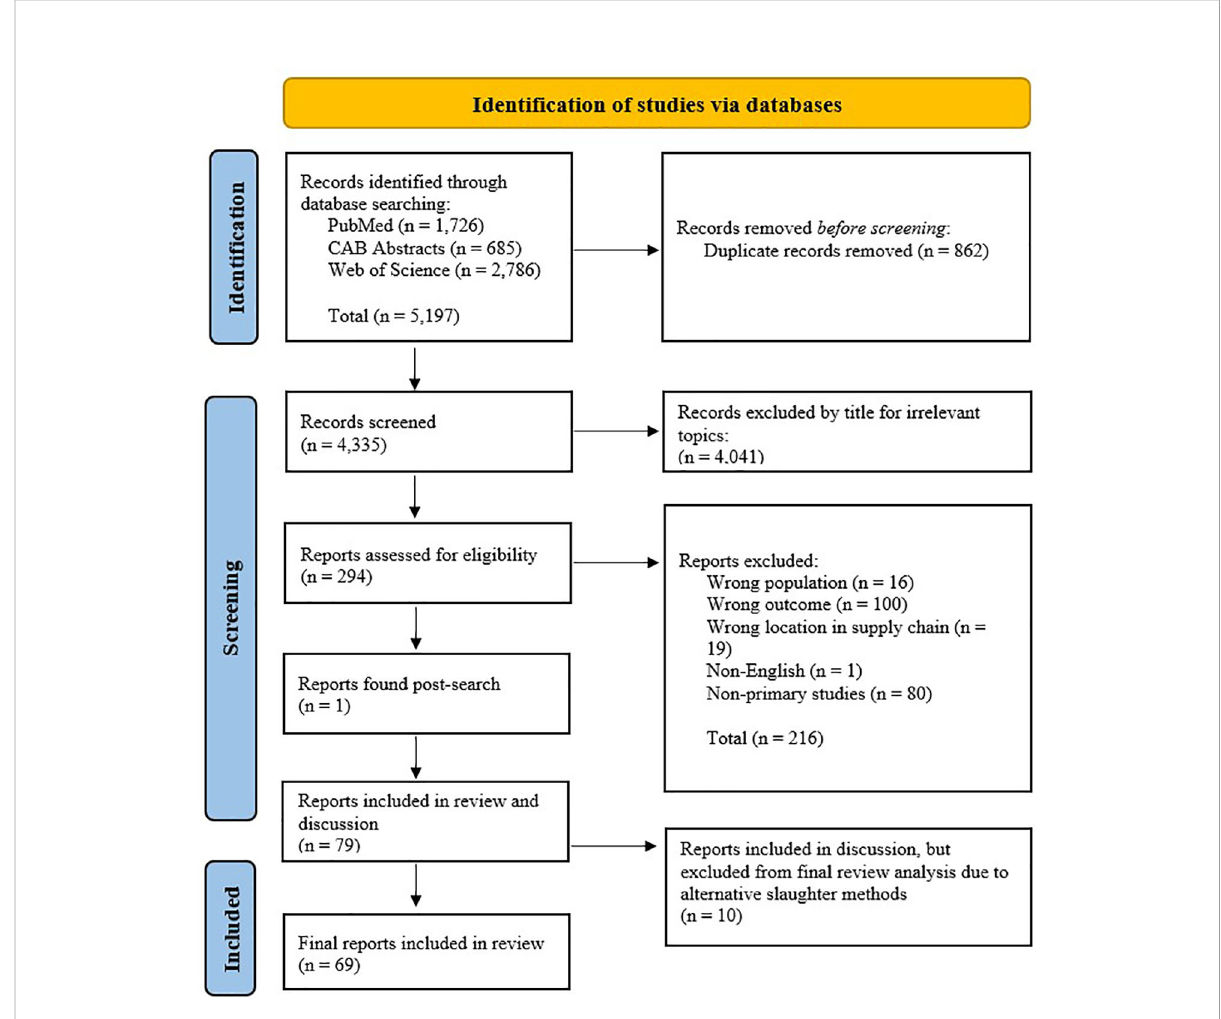
FIGURE 1 PRISMA fl ow diagram outlining the identi fi cation and inclusion of articles depicting pre-slaughter management factors and fed beef cattle welfare outcomes. Flow chart adapted from the PRISMA 2020 Statement (Page et al.,